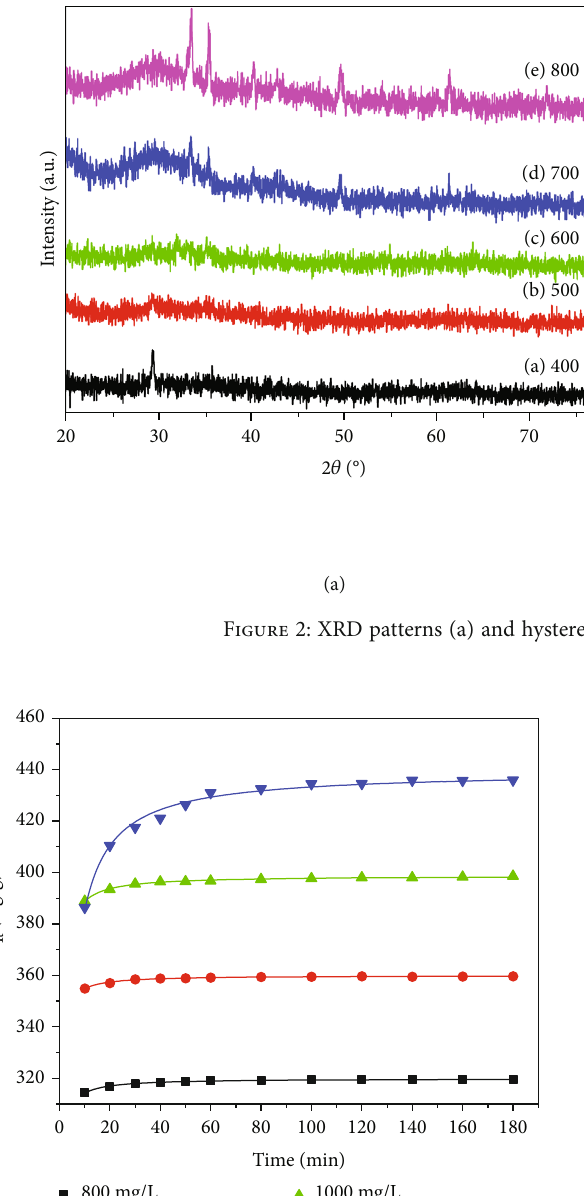
O nanosheets for 2 4